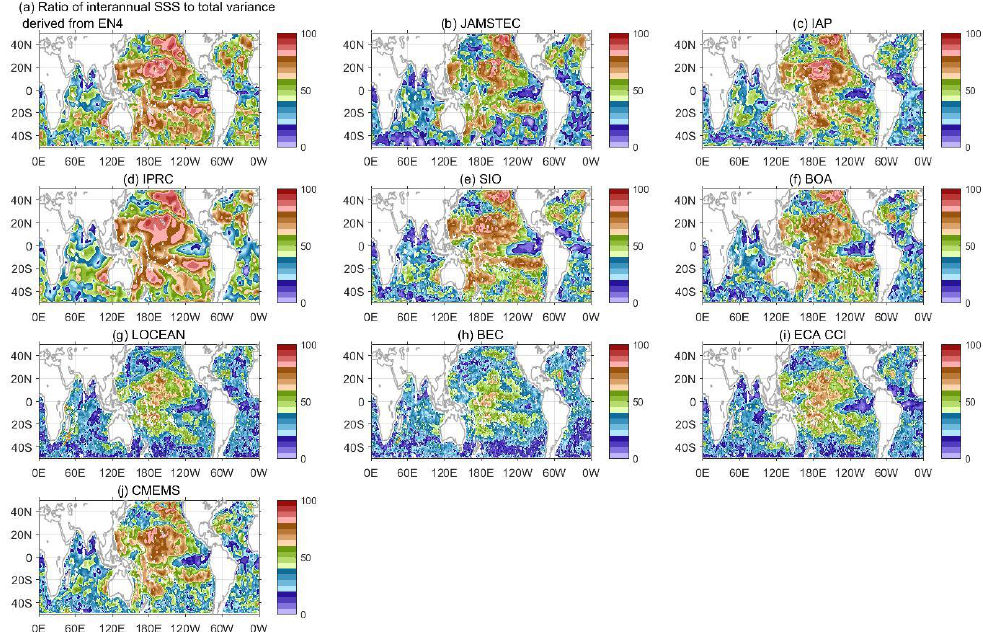
Figure 12. Percentage of the total SSS variance explained by interannual variability.